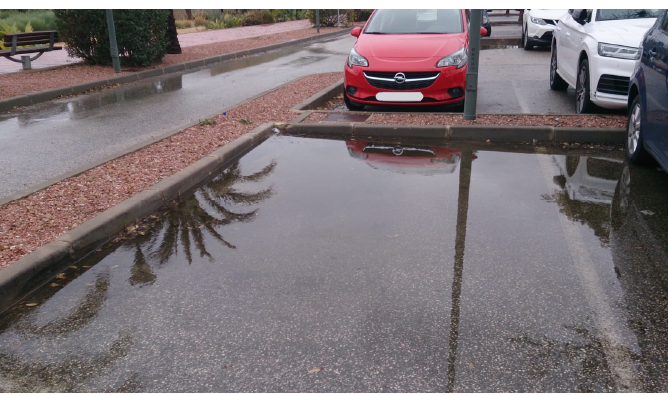
Figure 6. Flow accumulation in a parking lot of the study area with a total accumulated rainfall of 17.2 mm in 72 h (8 January 2021)